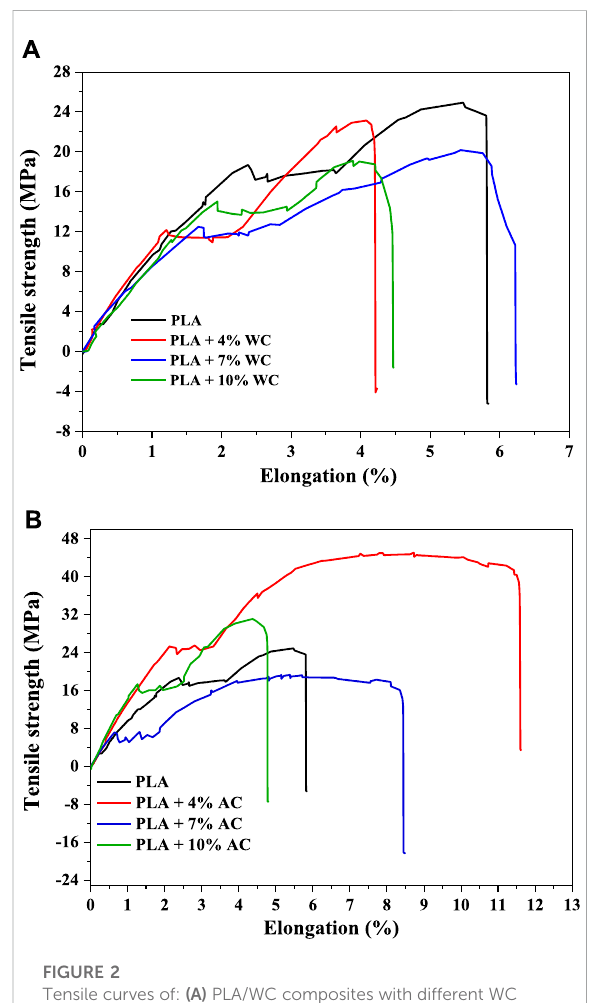
FIGURE 2 Tensile curves of: (A) PLA/WC composites with different WC loading; (B) PLA/AC composites with different AC